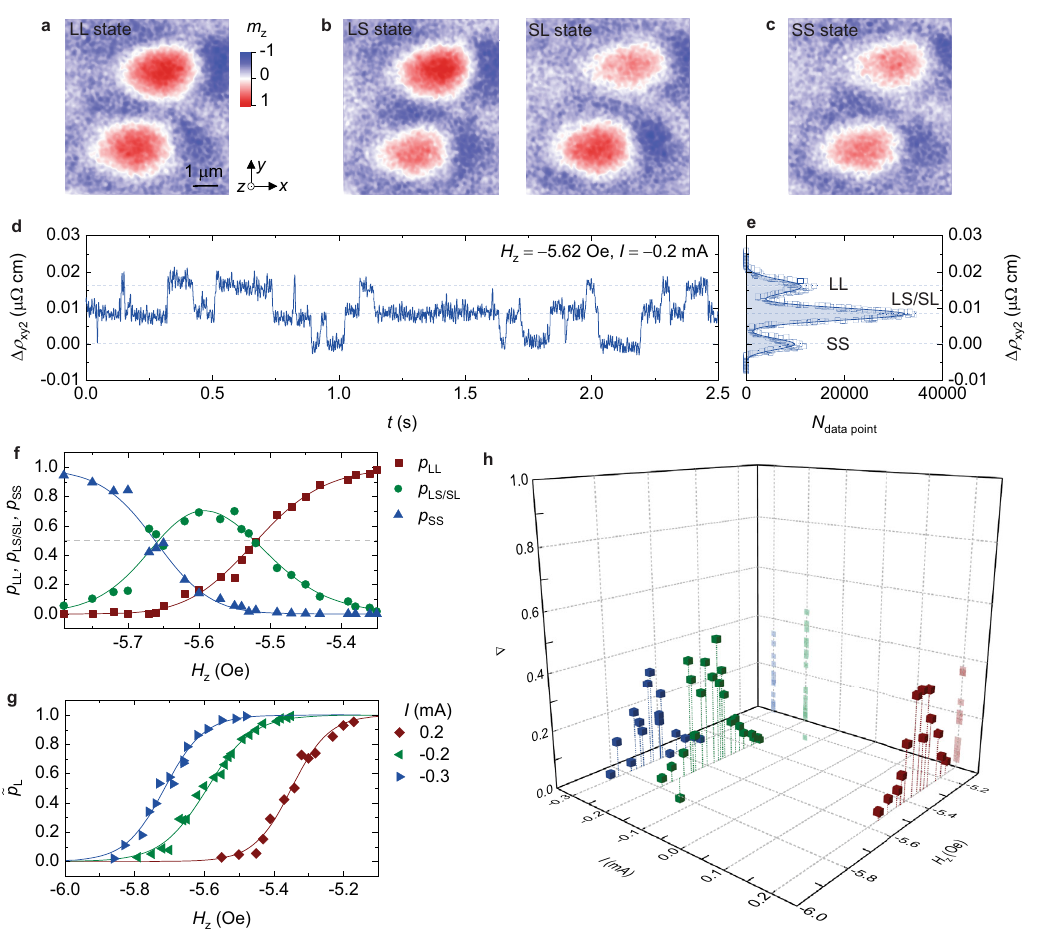
Fig. 3 Dynamic coupling between neighbouring skyrmions. a – c P-MOKE images of two neighbouring skyrmions at the LL, LS/SL and SS states, respectively. d Relative Hall-resistivity ( Δ ρ xy2 ) variations in time for the two skyrmions in ( a – c ). e Statistics of data point distributions ( N data point ), open dots) as a function of Δ ρ xy2 . Open dots are fi tted to Gaussian functions. The measurement is performed at H z = − 5.62 Oe and I = − 0.2 mA. f Field dependencies of p SS , p LS/SL and p LL probabilities at a current I = − 0.2 mA. Lines are to guide the eye. g , h The fi eld and current dependencies of e p L ( g ) and Δ ( h ) derived from p p p fi ts. All results are measured at 307.1 SS , LS/SL and LL probabilities. Lines in g are sigmoidal